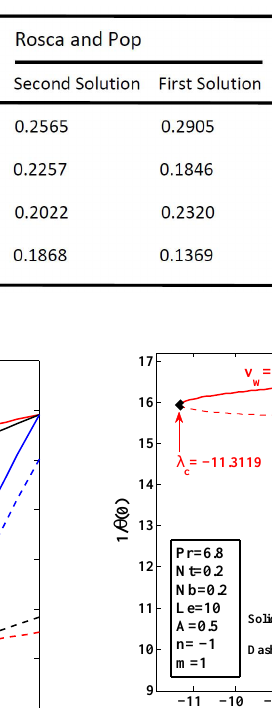
Table 1: The influence of the first-order slip parameter ( m ), second-order slip parameter ( n ) and transpiration rate parameter ( V w ) on f (cid:48)(cid:48) (0) for shrinking plate, and comparison with results of Rosca and Pop [24] and Fang et al. [30] for steady flow case ( A = 0) , when λ = −1.